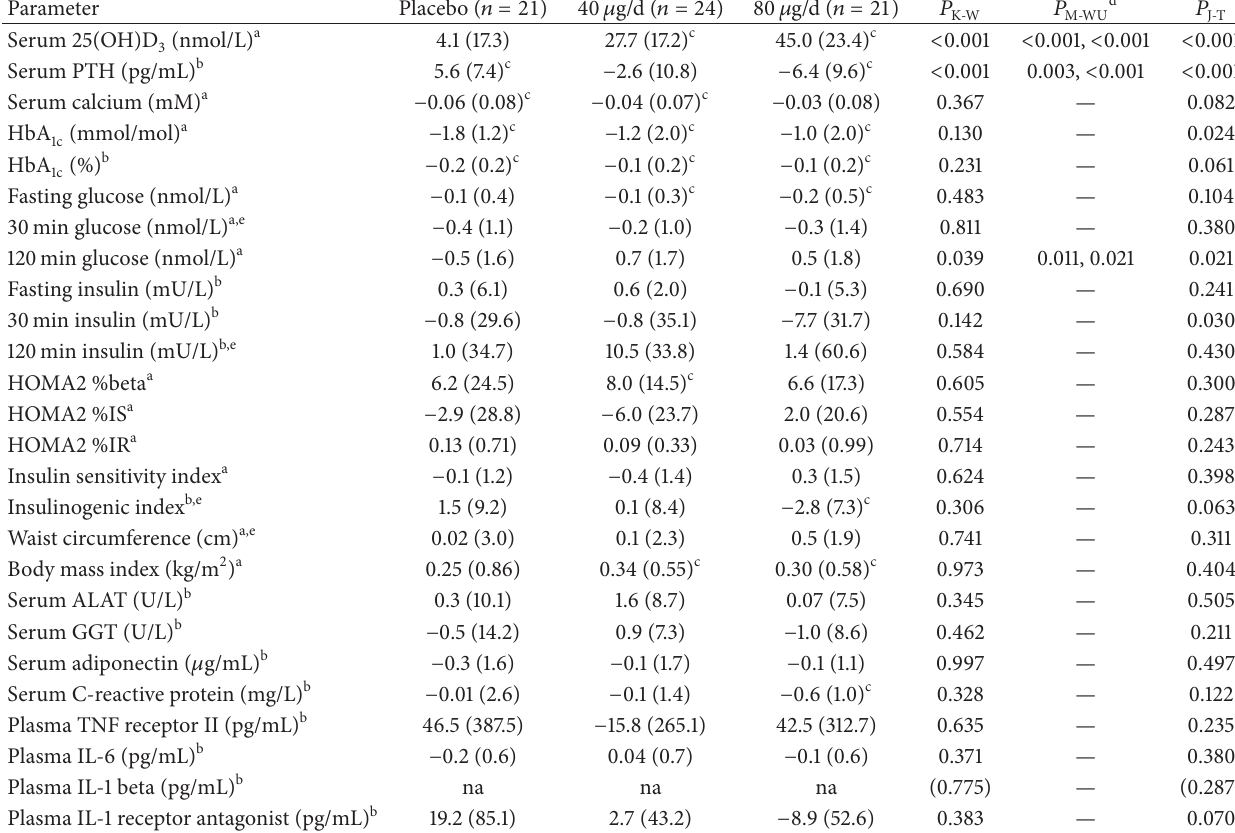
Table 2: Changes over time in the outcome parameters by supplementation group ( 𝑛 = 66